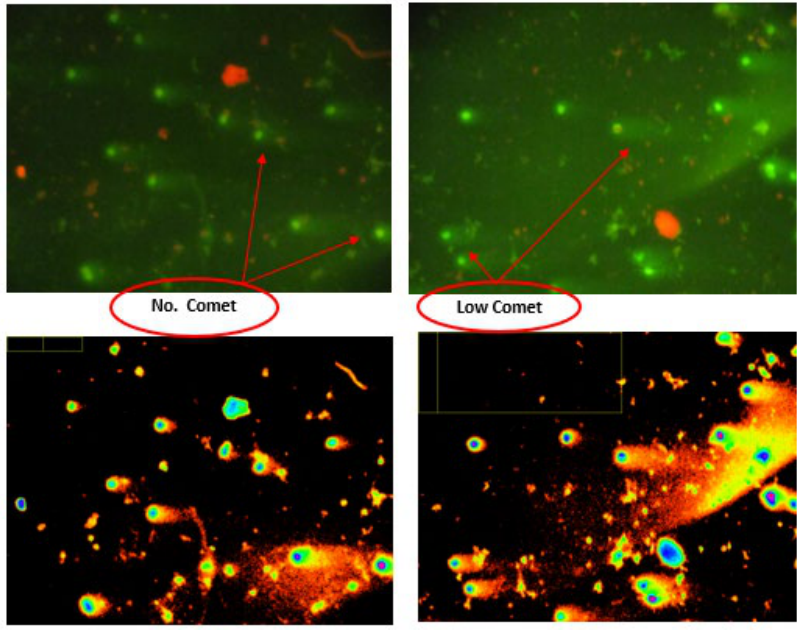
Figure 8. Treated group with Se NPs: high numbers of cells with no comet and low comet by using comet score program.